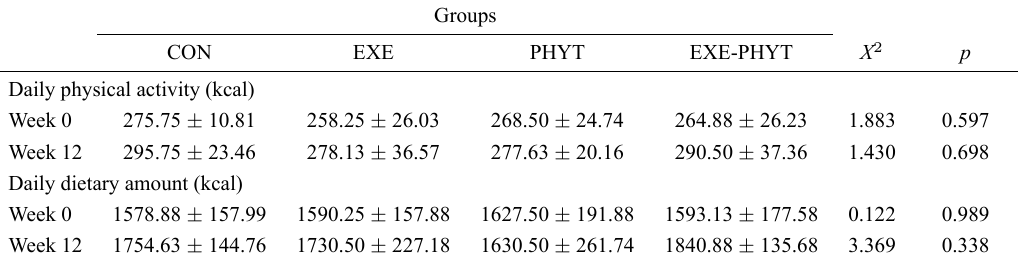
Table 4. Changes and differences in mean daily calorie intake and